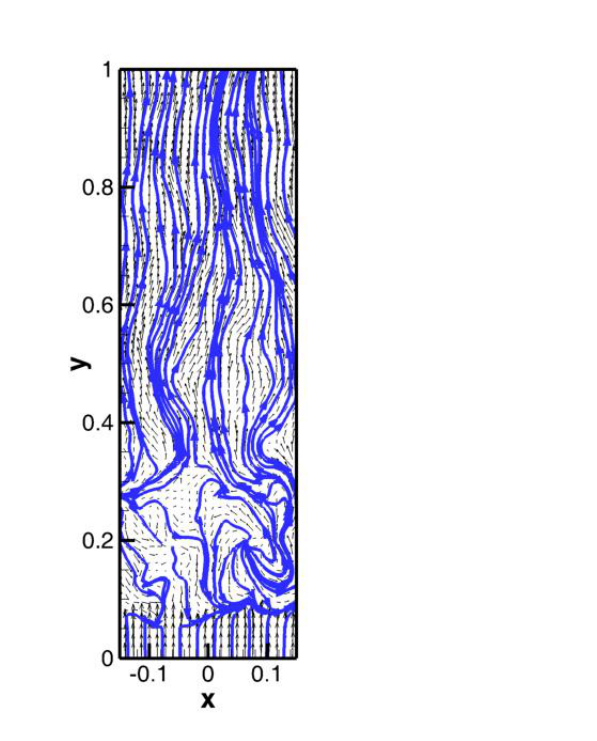
Fig. 2. Instantaneous velocity vectors .